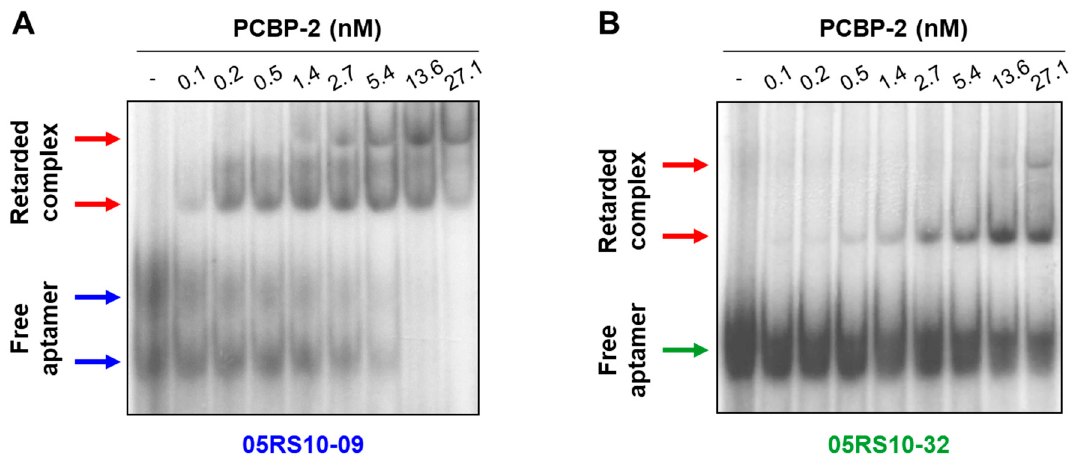
Figure 7. EMSA of the aptamer–target complexes formed by two RNA aptamers showing high affinity for PCBP-2: 05RS10-09 ( A ) and 05RS10-32 ( B ). The uncropped gel images, using short and long exposure times, are shown in Supplementary Figure S8.